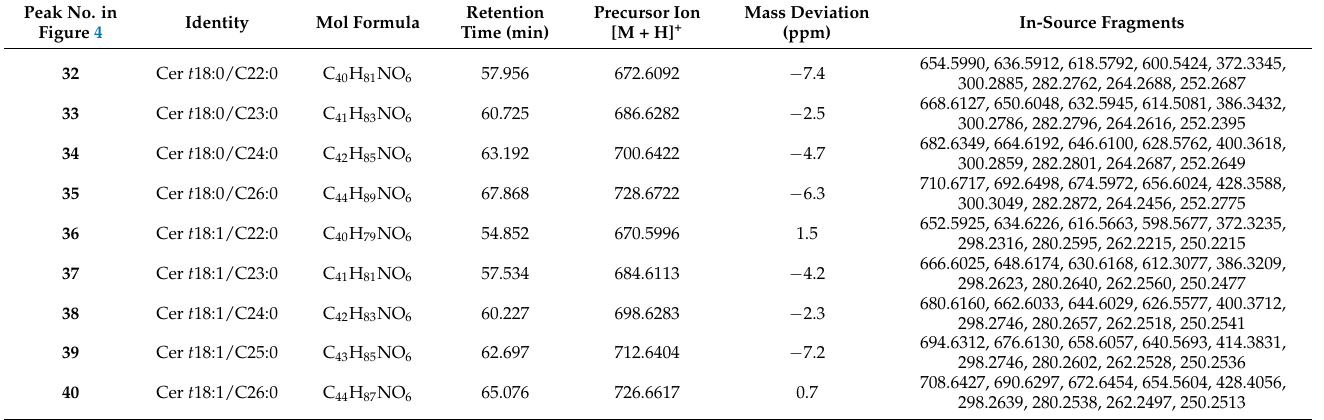
Table 3. Summary of precursor/product ion m / z values for ceramides molecular species- α , β